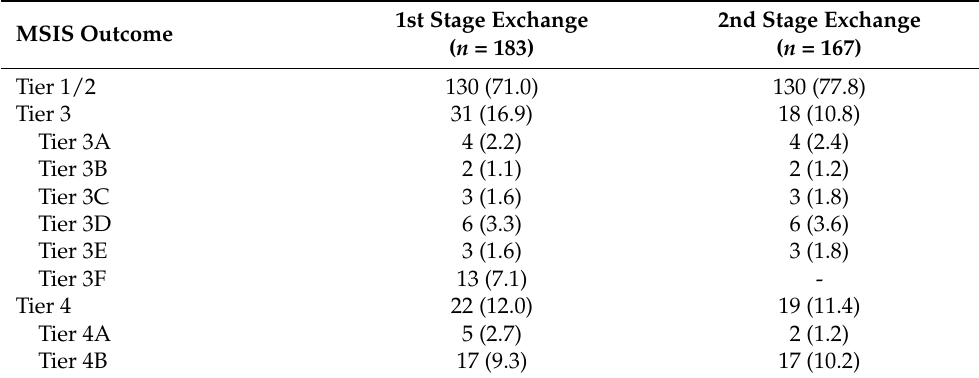
Table 3. Description of clinical outcomes using the MSIS outcome reporting tool at different starting points of treatment assessment. The numbers in parentheses represent the percentage of people in that tier.